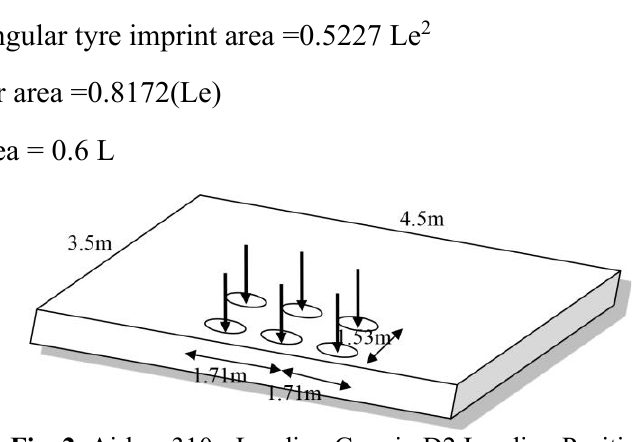
Fig. 2. Airbus 310 - Landing Gear in D2 Loading